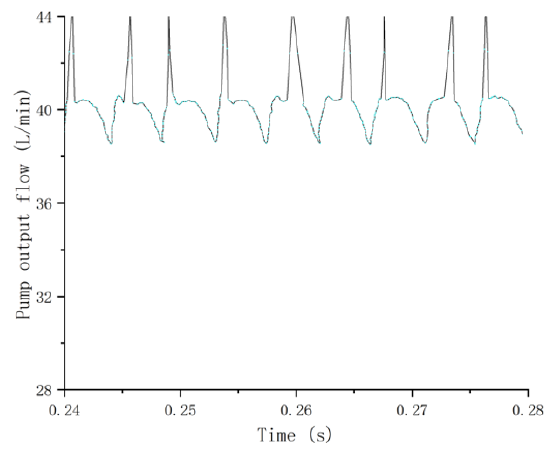
Figure 24. Experimental diagram of a 9-piston plunger pump.